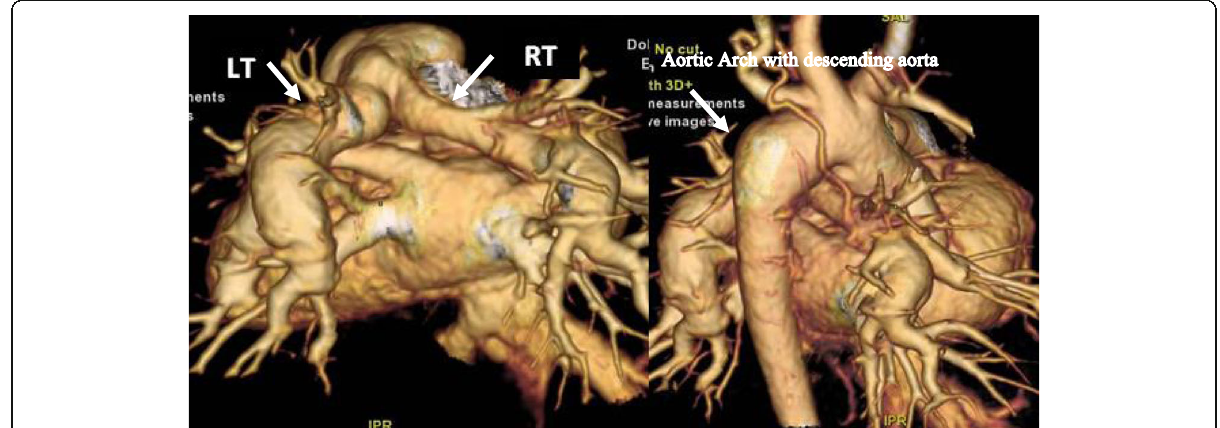
Fig. 2 Post total correction of TA with